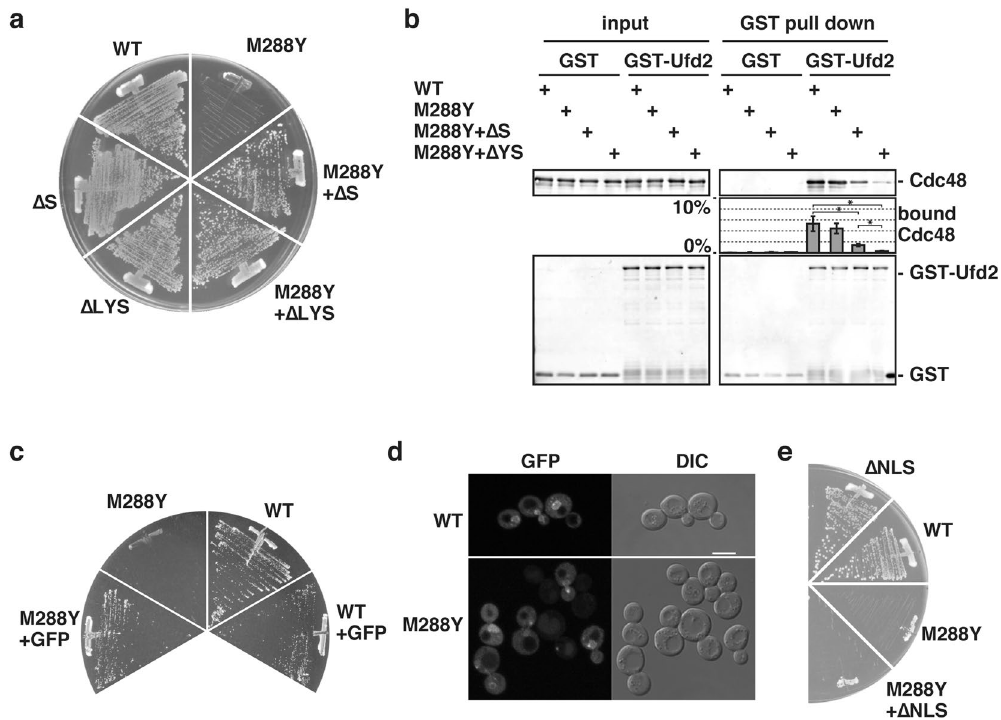
Figure 3. Mutations inhibiting interaction with the 20S proteasome rescued the M288 Φ lethal phenotype. ( a ) Tested were viabilities of cells expressing Cdc48 with the indicated mutations as shown in Fig. 1b. ∆ S and ∆ LYS, deletion of the C-terminal 1 and 3 amino acid residues of Cdc48, respectively. ( b ) GST and GST-Ufd2 were incubated with Cdc48 for 10 min. The GST proteins were isolated using glutathione beads, and eluted proteins from the beads were analyzed by SDS-PAGE followed by immunoblotting using anti-Cdc48 and anti- GST antibodies. Amounts of bound Cdc48 were quantified. input, 5% of GST pull down. ∆ YS, deletion of the C-terminal 2 amino acids residues. Averages and standard errors from three independent experiments were shown. Asterisks indicate significant differences with P < 0.05 by student t-test. ( c ) Tested were viabilities of cells expressing untagged Cdc48 and C-terminally GFP-attached Cdc48 with and without the M288Y mutation as shown in Fig. 1b. ( d ) Whole GFP signals within cells were collected by Z-scan by confocal fluorescence microscopy and projected into a 2D image. Representative GFP signals with bright field images (DIC) were shown. bars, 5 µ m. ( e ) Tested were viabilities of cells expressing Cdc48 with the M288Y mutation and a loss-of- function mutation in the nuclear localization signal ( ∆ NLS) as shown in Fig.